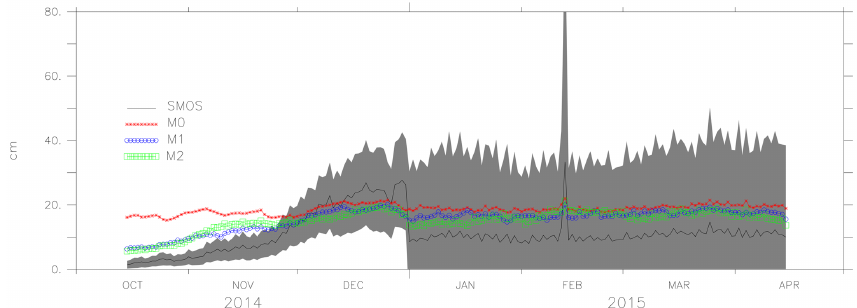
Figure 12. The ice thickness from the models M0, M1, M2 and observation (SMOS ice thickness) and the observation uncertainty (shaded grey) for SMOS ice thickness less than 30cm (2014–2015).